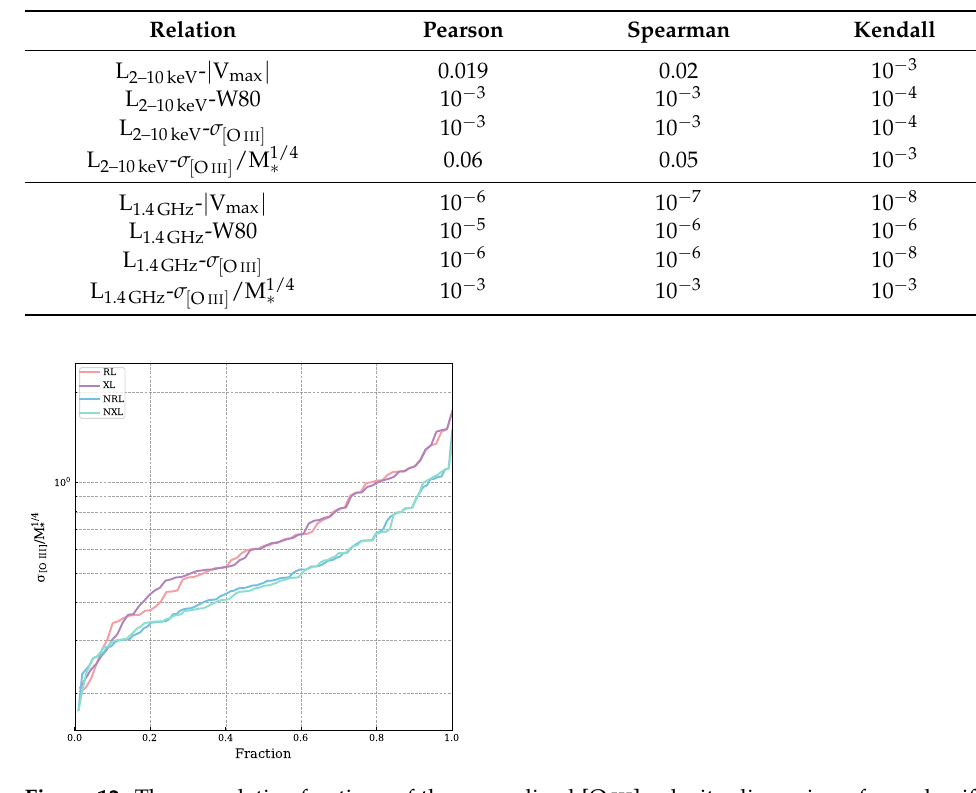
Table 2. p -values of Partial Correlation Analyses.